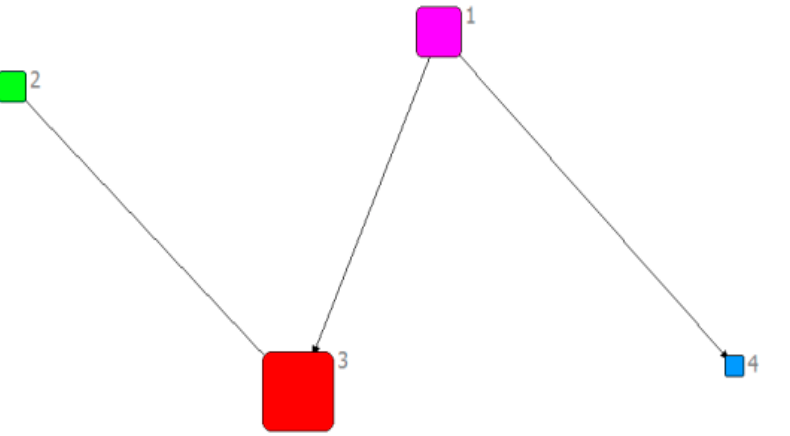
Figure 1. Relationship among knowledge-based elements.